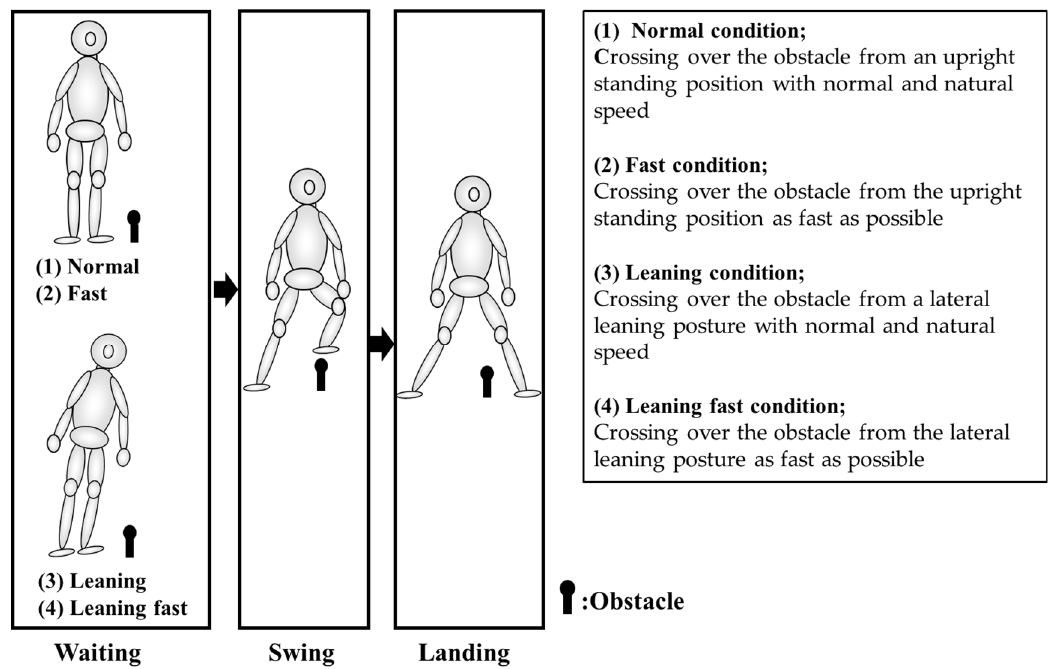
Figure 1. Crossing